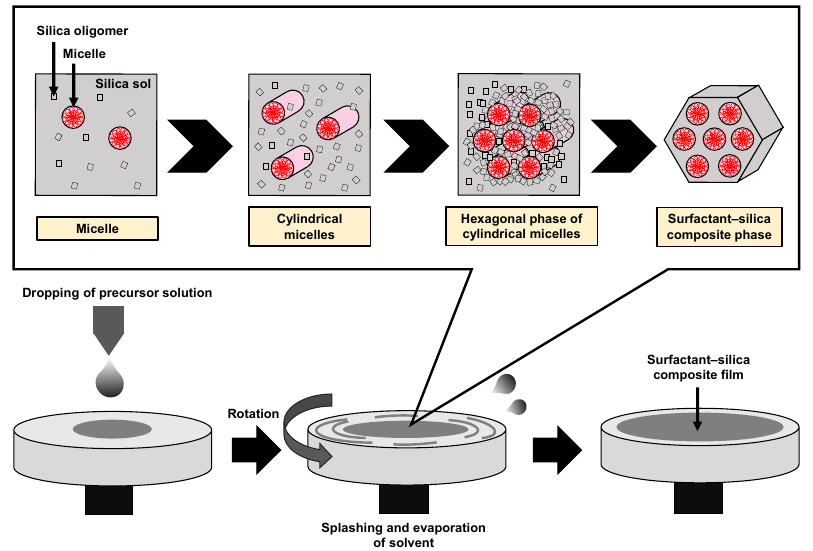
Figure 8. Illustration of the formation of the surfactant–silica composite film in the spin-coating process.